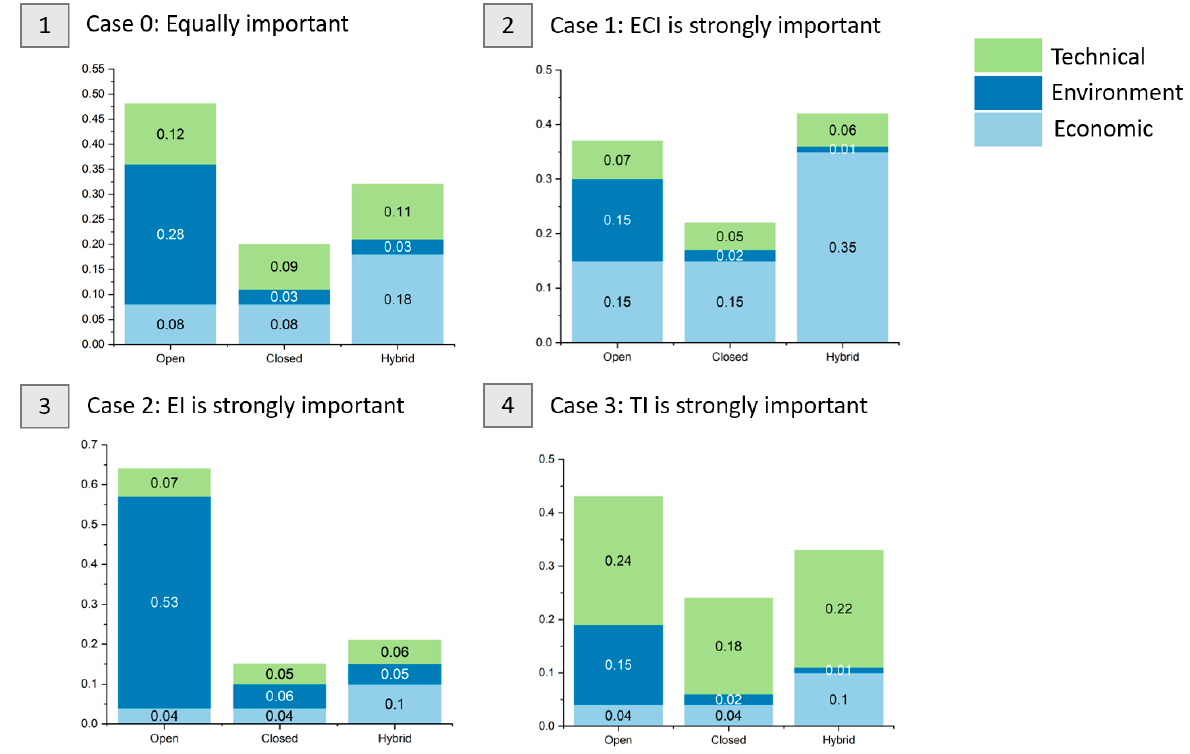
Figure 11. Results of MCDA (Fuzzy-AHP) ; the lower is the better.